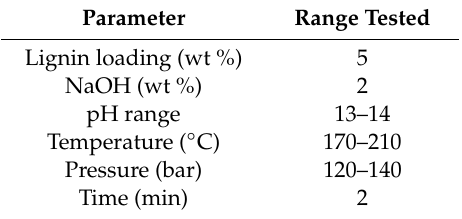
Table 1. The experimental conditions of black liquor retentate (BLR)